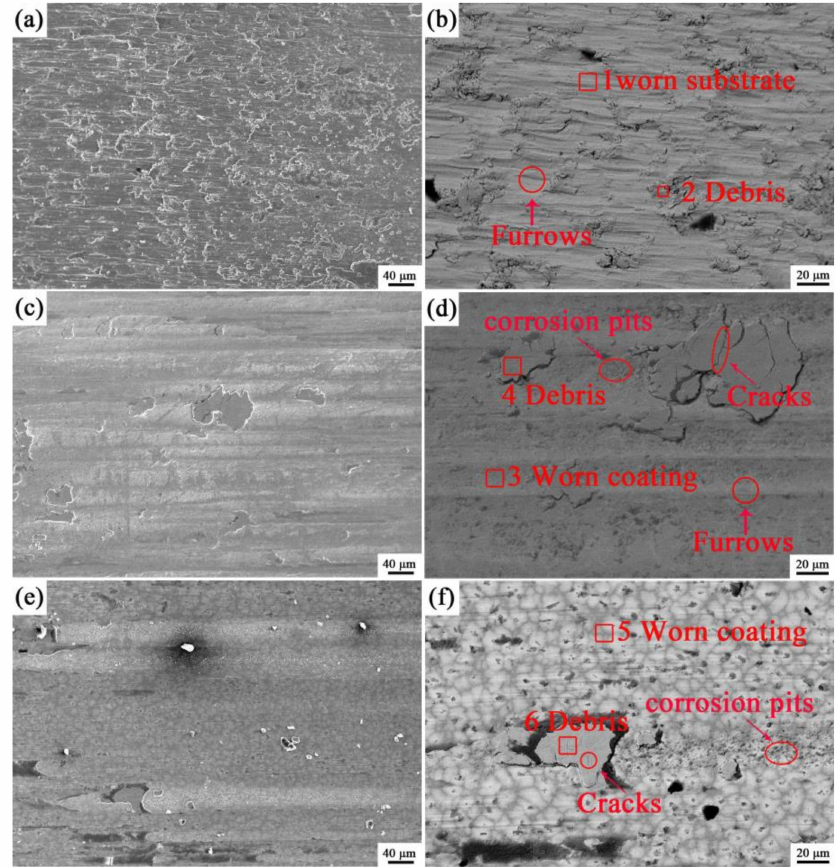
Figure 9. Wear morphologies of substrate and coatings subject in neutral environment: ( a , b ) substrate; ( c , d ) coating without Ta; ( e , f ) coating with Ta.